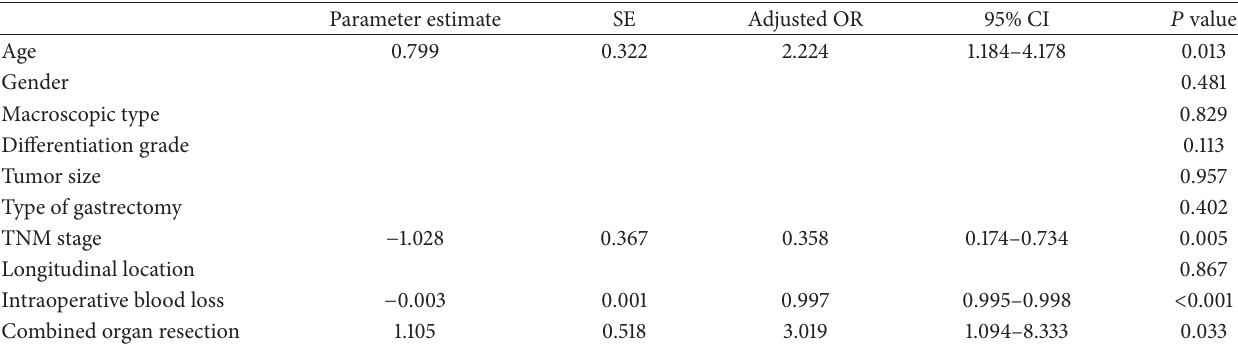
Table 4: Multivariate analysis of risk factors for blood transfusion in patients with POHb > 100